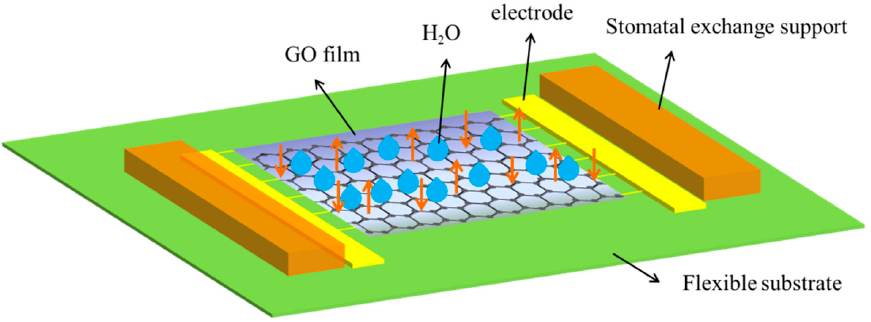
Figure 1. Schematic of the structure of the flexible devices.